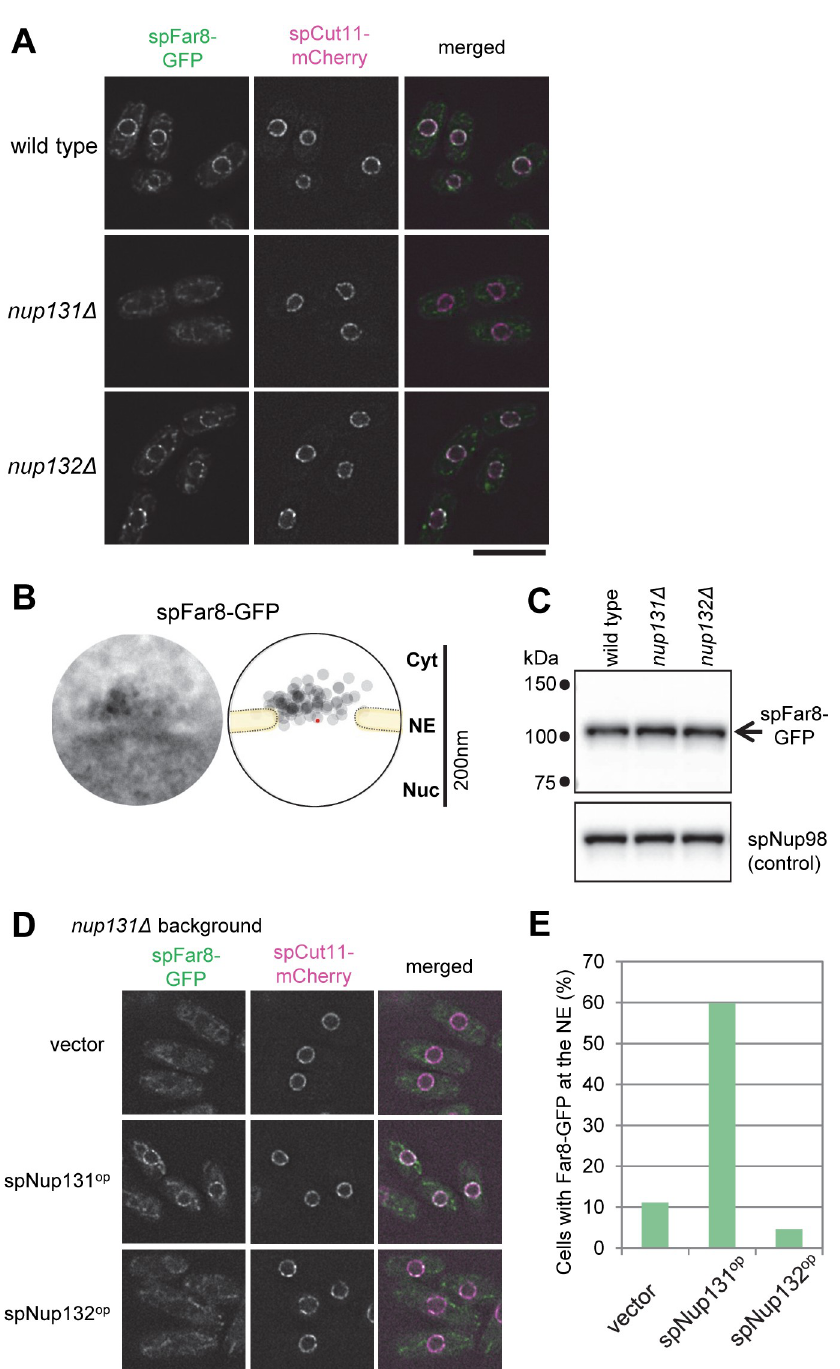
Fig 2. spNup131 is required for spFar8 localization on the cytoplasmic side of the NPC. (A) Localization of spFar8-GFP in wild type, nup131 Δ , and nup132 Δ cells. spFar8-GFP was expressed in the indicated strains, and cells exponentially growing in EMM2 liquid medium were observed by FM. Single section images of the same focal plane are shown. spCut11-mCherry was observed as an NPC marker. Scale bar, 10 μ m. (B) IEM of spFar8-GFP. For quantitative representation, a montage image of 20 immunoelectron micrographs and a schematic drawing illustrating the distribution of immunogold particles are shown. The red point indicates the pore center. IEM micrographs used for the quantitative analysis are available in S3 Dataset. (C) Western blot analysis of spFar8-GFP. Whole cell extracts were prepared from wild type, nup131 Δ , and nup132 Δ cells expressing spFar8-GFP and subjected to SDS-PAGE and Western blot analysis. spFar8-GFP was detected with anti-GFP antibody. spNup98 was detected with